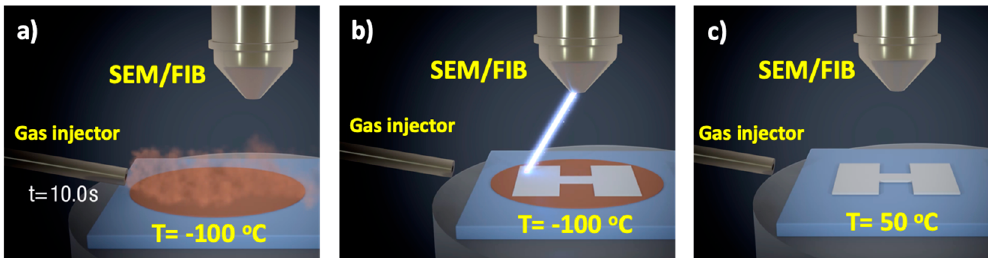
Figure 2. The three main steps of FEBID and FIBID under cryogenic conditions are sketched: ( a ) The precursor is dosed for a given time on a cooled substrate, giving rise to a condensed layer of precursor; ( b ) The focused electron or ion beam irradiates the precursor condensed layer with the wanted pattern; ( c ) The substrate is heated to above room temperature, which produces the sublimation of the unirradiated precursor and the emergence of the desired deposit.